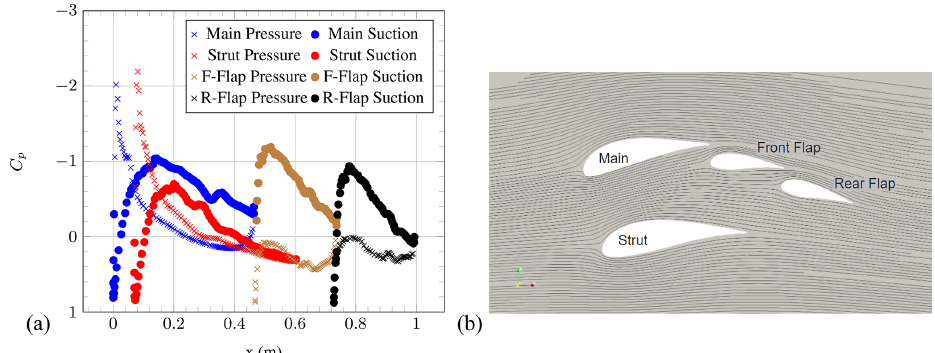
Figure 8. (a) Pressure coefficient of the individual element airfoils and (b) streamlines at AoA = 6 ◦ (OpenFOAM simulations).